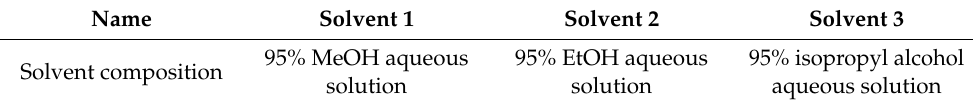
Table 2. Investigation of different solvents in one crystallization.